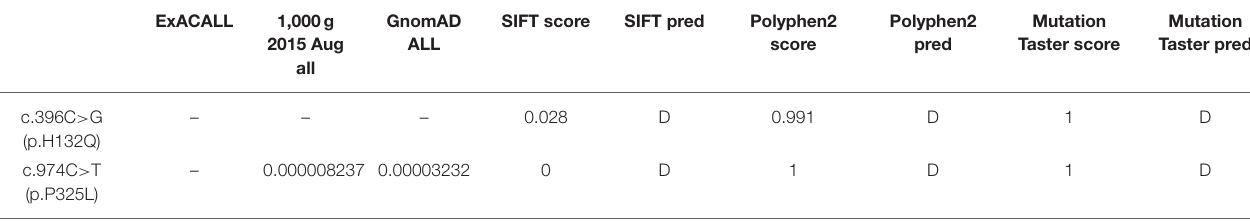
TABLE 1 | Bioinformatic analysis of GALT